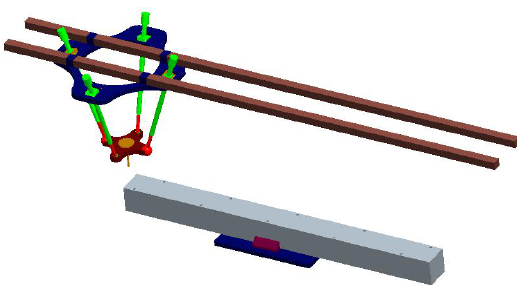
Figure 10: The machining simulation model